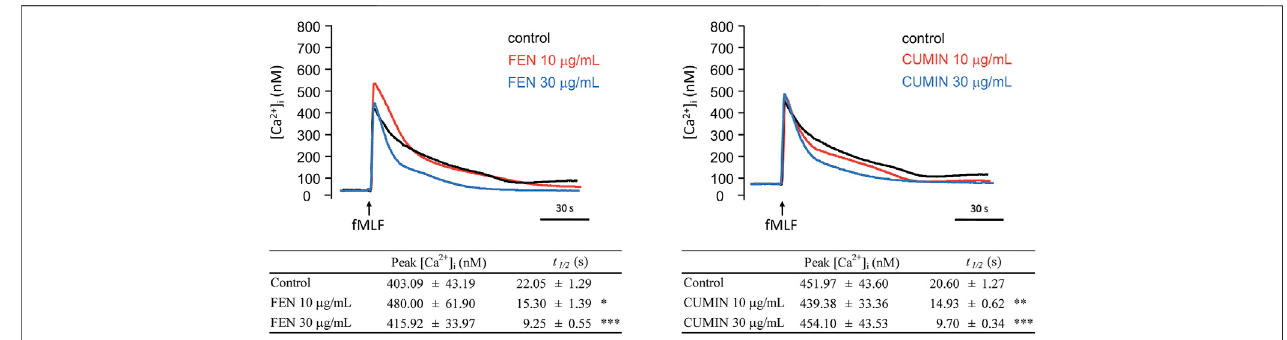
FIGURE 6 | Fennel (FEN) (left) and cumin (CUMIN) (right) volatile oils inhibit calcium mobilization in fMLF-activated human neutrophils. A Fluo-3/AM-labeled neutrophils were incubated with DMSO (as control), fennel (FEN, 10 – 30 μ g/ml, left), or cumin (CUMIN, 10 – 30 μ g/ml, right) volatile oils and then activated with fMLF (0.1 μ M) in the presence of Ca 2+ (1 mM). Fluorescence was continuously monitored at 37 ° C with stirring. All data are presented as mean ± S.E.M. ( n (cid:2) 4 – 6). * p < 0.05, * p < 0.01, *** p < 0.001 compared with the control (fMLF only).